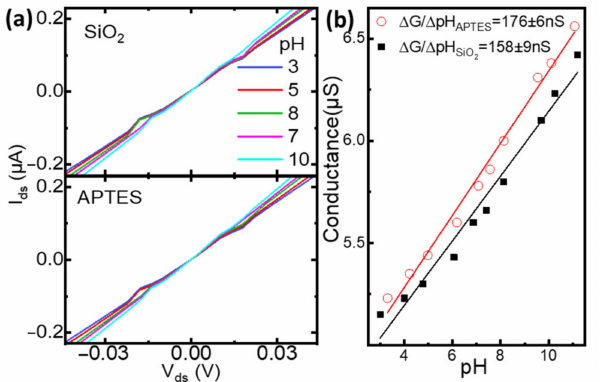
Figure 5. ( a ) Output characteristics of the FinFET device 1 measured before and after the APTES silanization process at different buffer pH values (3, 5, 7, 8, 10) shown in different colors (blue, red, green pink and light blue, respectively). ( b ) Scatter plot showing the variation of conductance (G) in the FinFET, evaluated from the output characteristics as a function of buffer pH (varied from 3 to 11) before (black squares) and after the silanization process (red open circles). The linear fits of the scatter plots are shown as black and red lines for before and after APTES silanization, respectively. The average conductance change ( ∆ G/ ∆ pH) is also shown in the inset. For these experiments V GS =